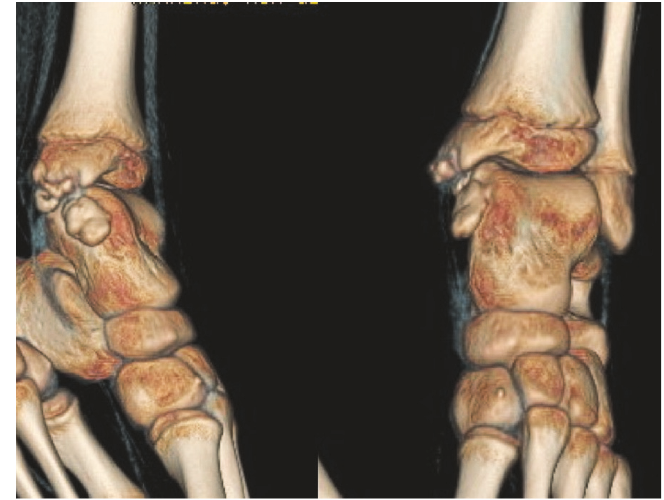
Figure 7: 3D reconstruction CT scan showing medial lobulated bony